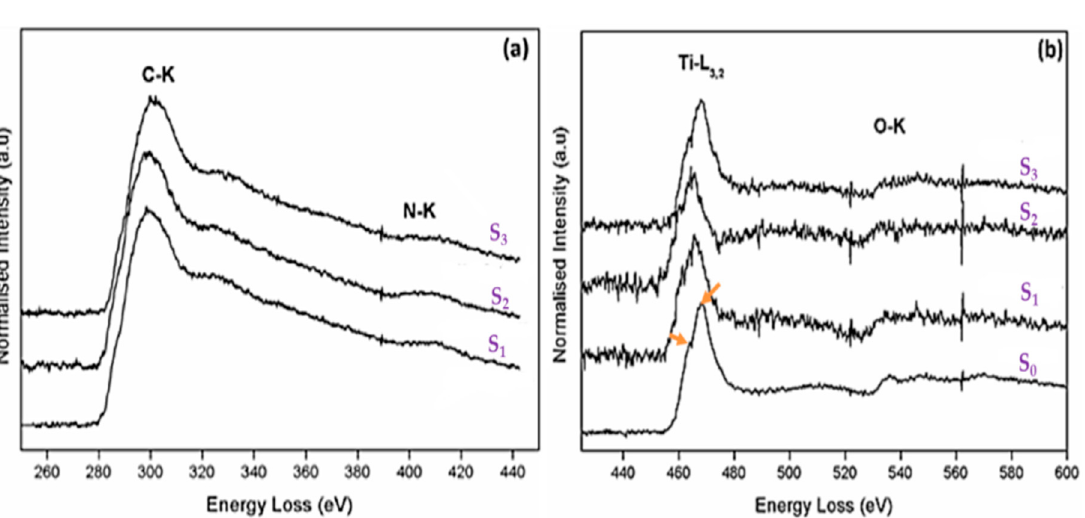
Figure 2. ( a ) FTIR spectra and ( b ) thermal gravimetric analysis (TGA) of C–N–TiO 2 nano composites pyrolysed in nitrogen gas at 350 °C and held at temperature for different times 105, 120 and 135 min.